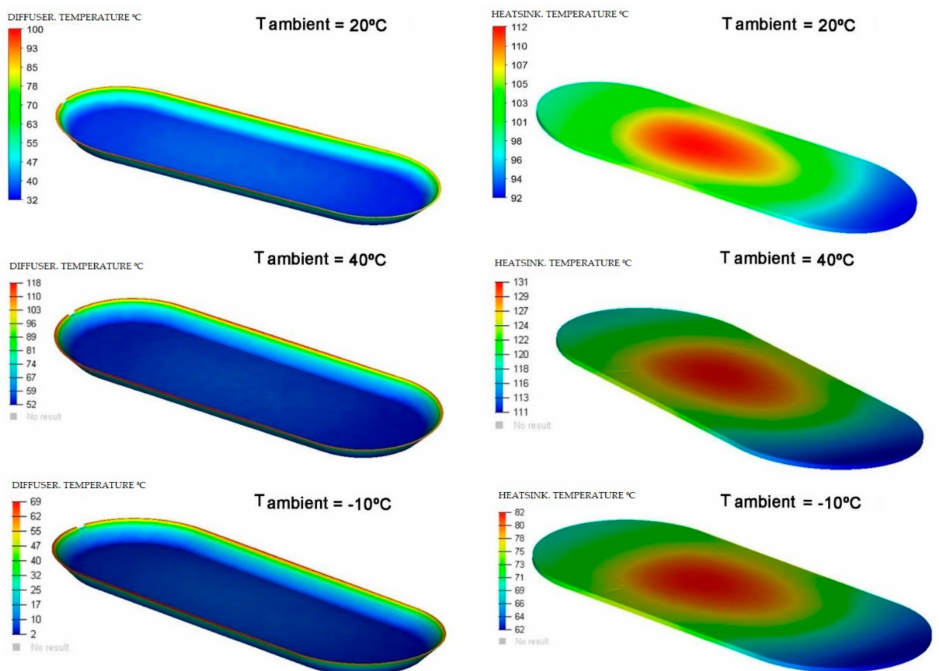
Figure 16. Comparison of dissipation of the diffuser ( left ) and of the heatsink ( right ) for different simulation temperatures. Source: our own elaboration from the software HyperView.